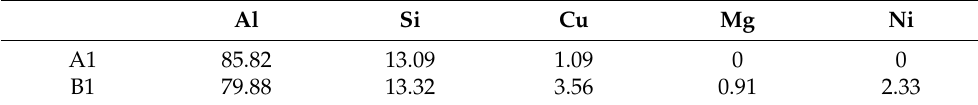
Table 1. Chemical composition of A1, B1 alloy (wt. %).